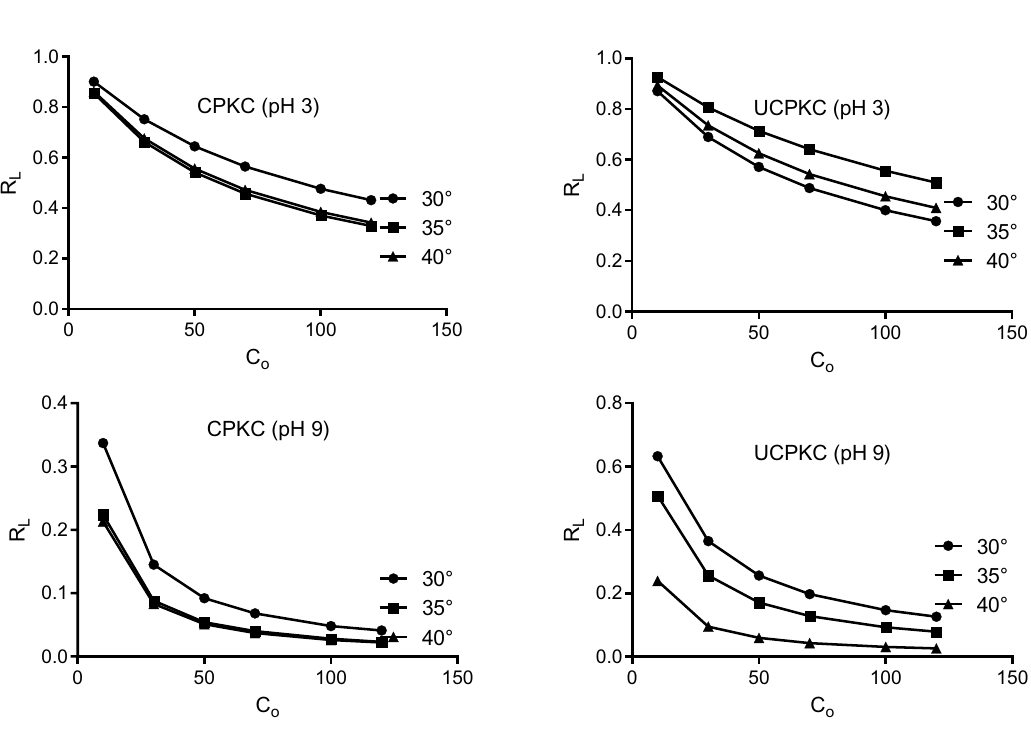
Figure 4. Plots of Langmuir separation factor for different temperatures and